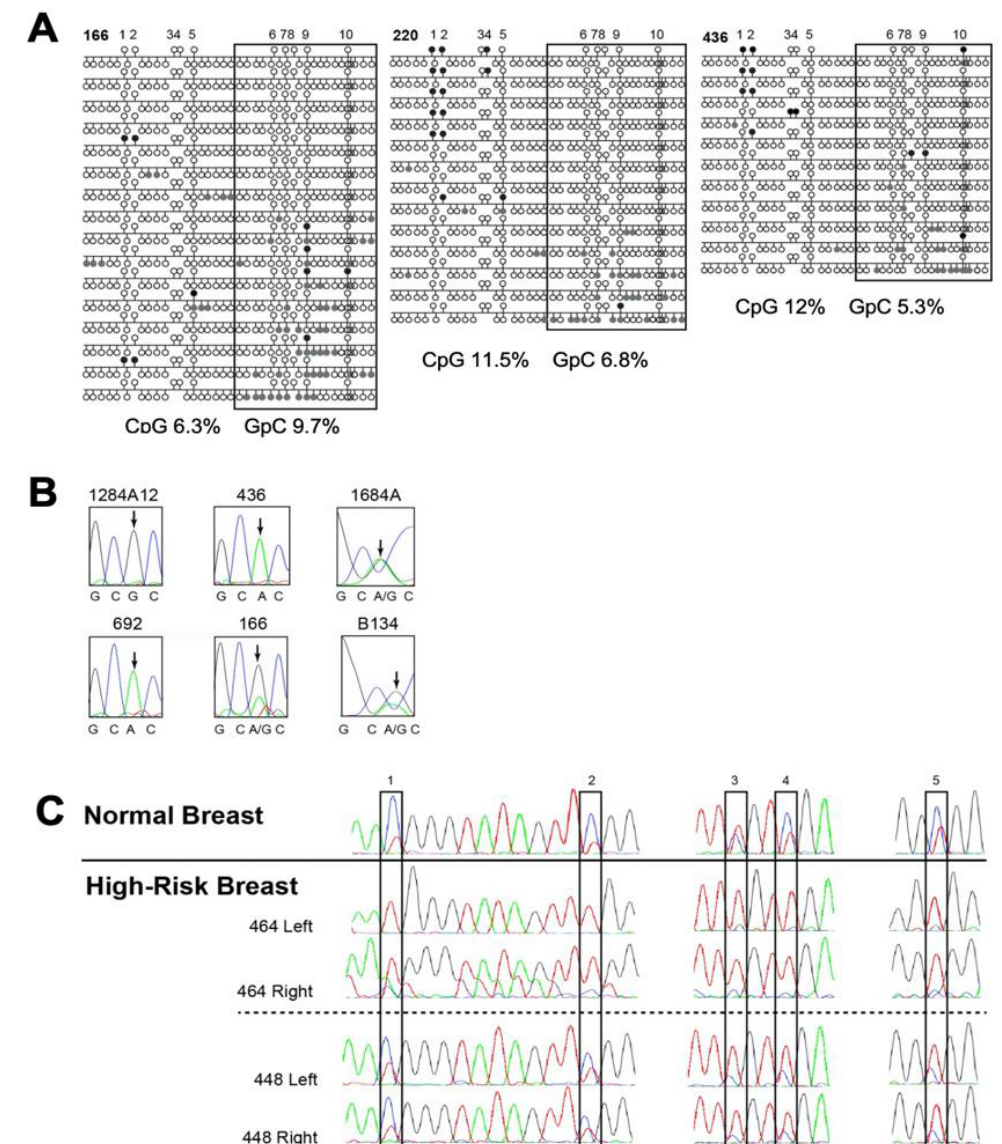
Figure 3. DNA methylation of KCNK9 -US1 DMR in breast cancer and microdissected mammary epithelial cells aspirates from women at high risk for breast cancer. ( A ) NOMe-Seq of the cloned KCNK9 -US1 DMR from breast cancer cores (166, 220, and 436). Upper circles—CpG sites (in vivo methylation: open circle, unmethylated cytosine; black filled circle, methylated cytosine). Lower circles—GpC sites (in vitro methylation, chromatin structure dependent: open circle, unmethylated cytosine, closed chromatin; gray filled circle, methylated cytosine, open chromatin). Boxed region—area of transcription factor binding from ENCODE data. ( B ) Sequences of coding SNP rs2615374 (A/G) in cDNA from tumor cores (1284A12, 436, 1684A, 692, and 166) and normal epithelial cells (B134) heterozygous for the SNP. The position of rs2615374 used to determine allelic expression is indicated by the arrows. ( C ) Hypomethylation at CpG sites 1 to 5 (boxes) in the KCNK9 -US1 DMR in DNA from non-cancerous mammary epithelial cell aspirates from women who are at high risk for developing breast cancer. Differentially methylated region (DMR).